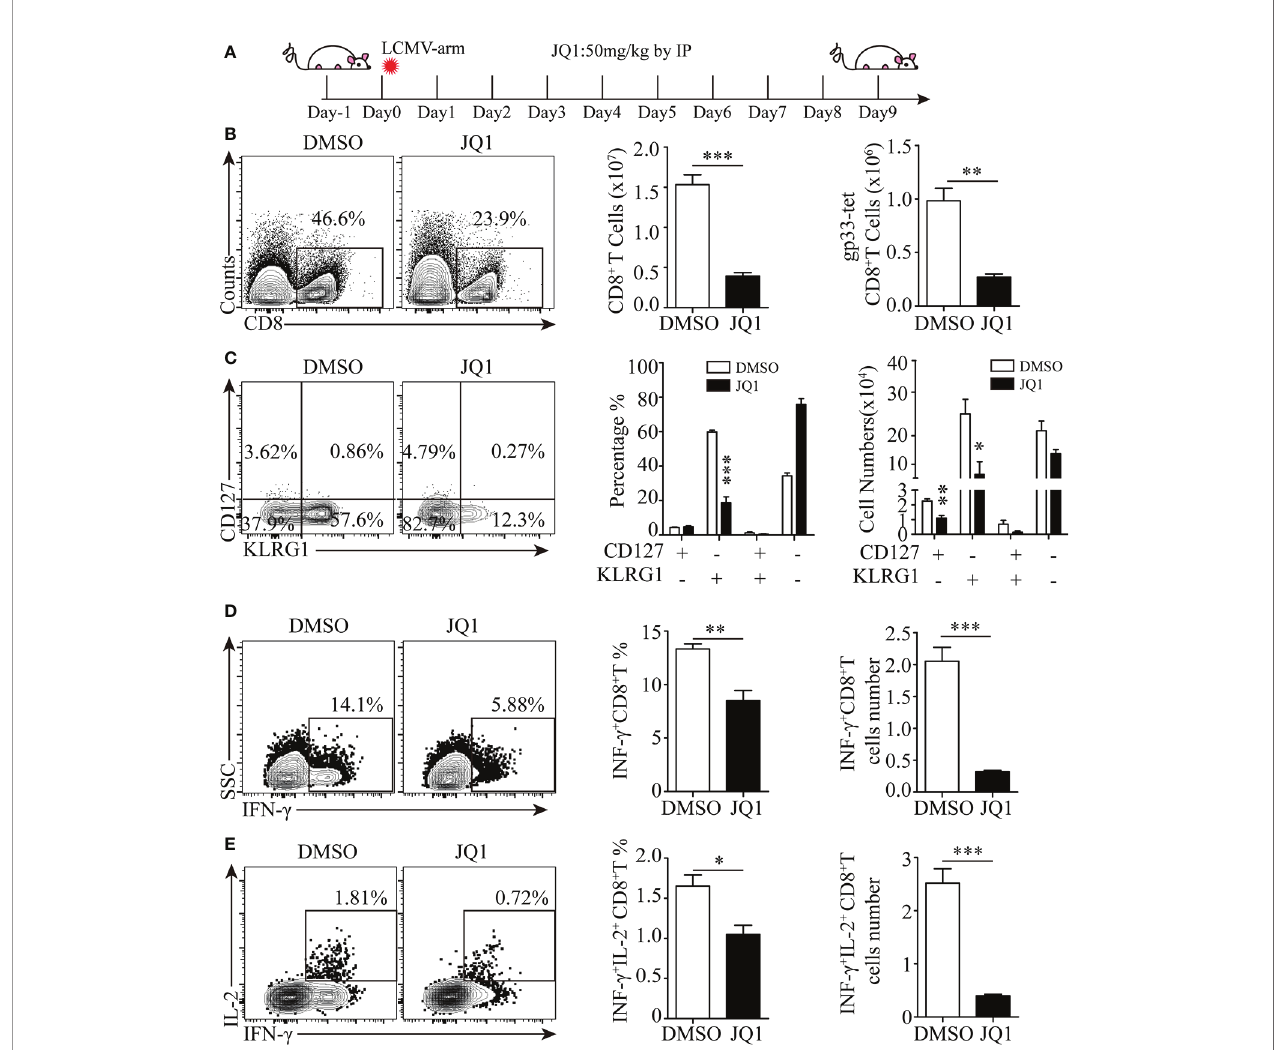
FIGURE 7 | Targeting Brd4 with inhibitors dampens effector CD8 + T cells-mediated antiviral immunity. (A) Experiment design. (B) Flow cytometry showing the expression of CD8 (left), the quanti fi cation of total CD8 + T cells (middle) and the quanti fi cation of LCMVgp33 epitope-speci fi c CD8 + T cell numbers (right). (C) Flow cytometry showing the expression of KLRG1 and CD127 in LCMVgp33 epitope-speci fi c CD8 + T cells from mice treated with JQ1 or DMSO at day 8 post-infection (left) and the frequency and number of each subset (right). (D, E) Flow cytometry analysis of indicated cytokines production after peptide stimulation in CD8 + T cells from mice treated with JQ1 or DMSO (left) and the number and frequency (right) of cytokine-producing CD8 + T cells. The data were analyzed by two-tailed unpaired t -test between two independent groups. Results were indicated as mean ± sem (error bars). *p < 0.05; **p < 0.01; ***p < 0.001. Each group includes at least 4 mice and each experiment repeats more than 2